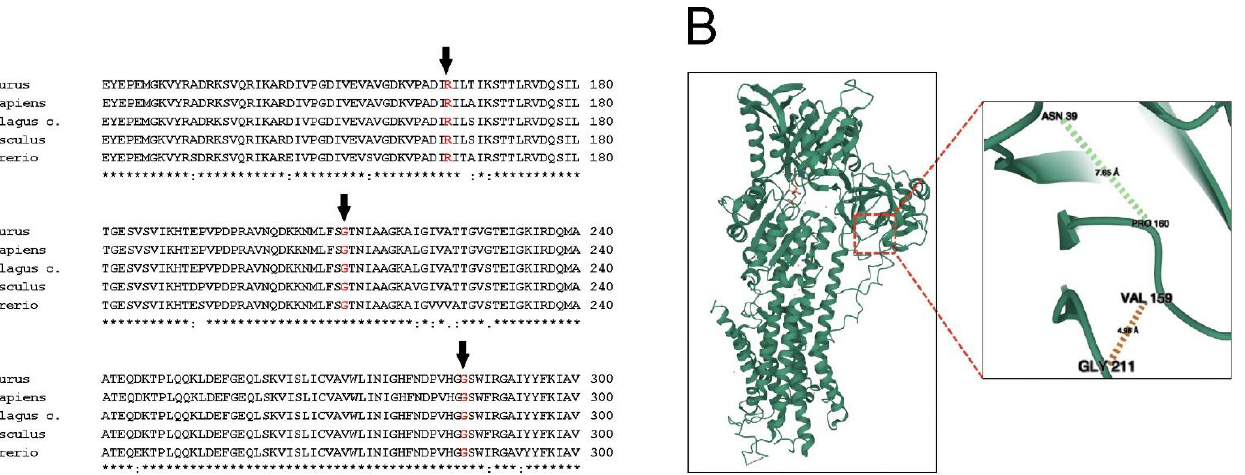
Figure 6. Cross-species SERCA1 amino acid sequence comparison and graphic representation of SERCA1 protein of bovine origin (PDB ID 3TLM). ( A ) Multiple sequence alignment of bovine SERCA1 with its orthologs. Only the sequence around the R164H and G211V/G286V mutations, found in Chianina , as well as Romagnola , and exclusively in Romagnola cattle breeds, is shown respectively. Amino acid substitutions are indicated by arrows. A high degree of conservation of amino acid residues is shown to occur not only across mammals but also between zebrafish and mammalian SERCA1 sequences. ( B ) Detail of domain A with the Gly211 amino acid (pathogenic in Romagnola ) is shown.